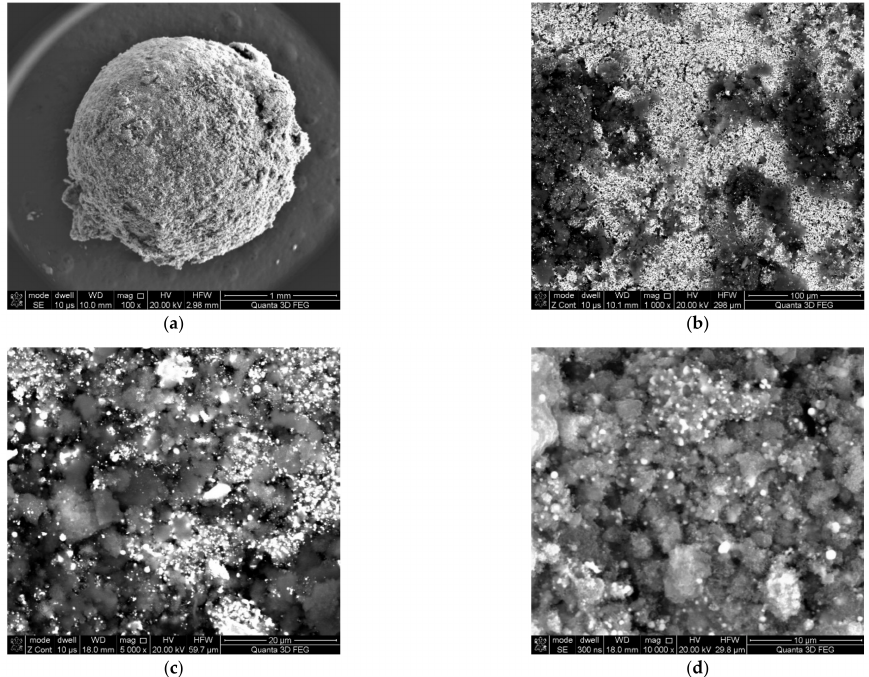
Figure 3. SEM images of the catalyst surface used. ( a ) catalyst granule, ( b ) 1000-fold magnification, ( c ) 5000-fold magnification, ( d ) 10,000-fold